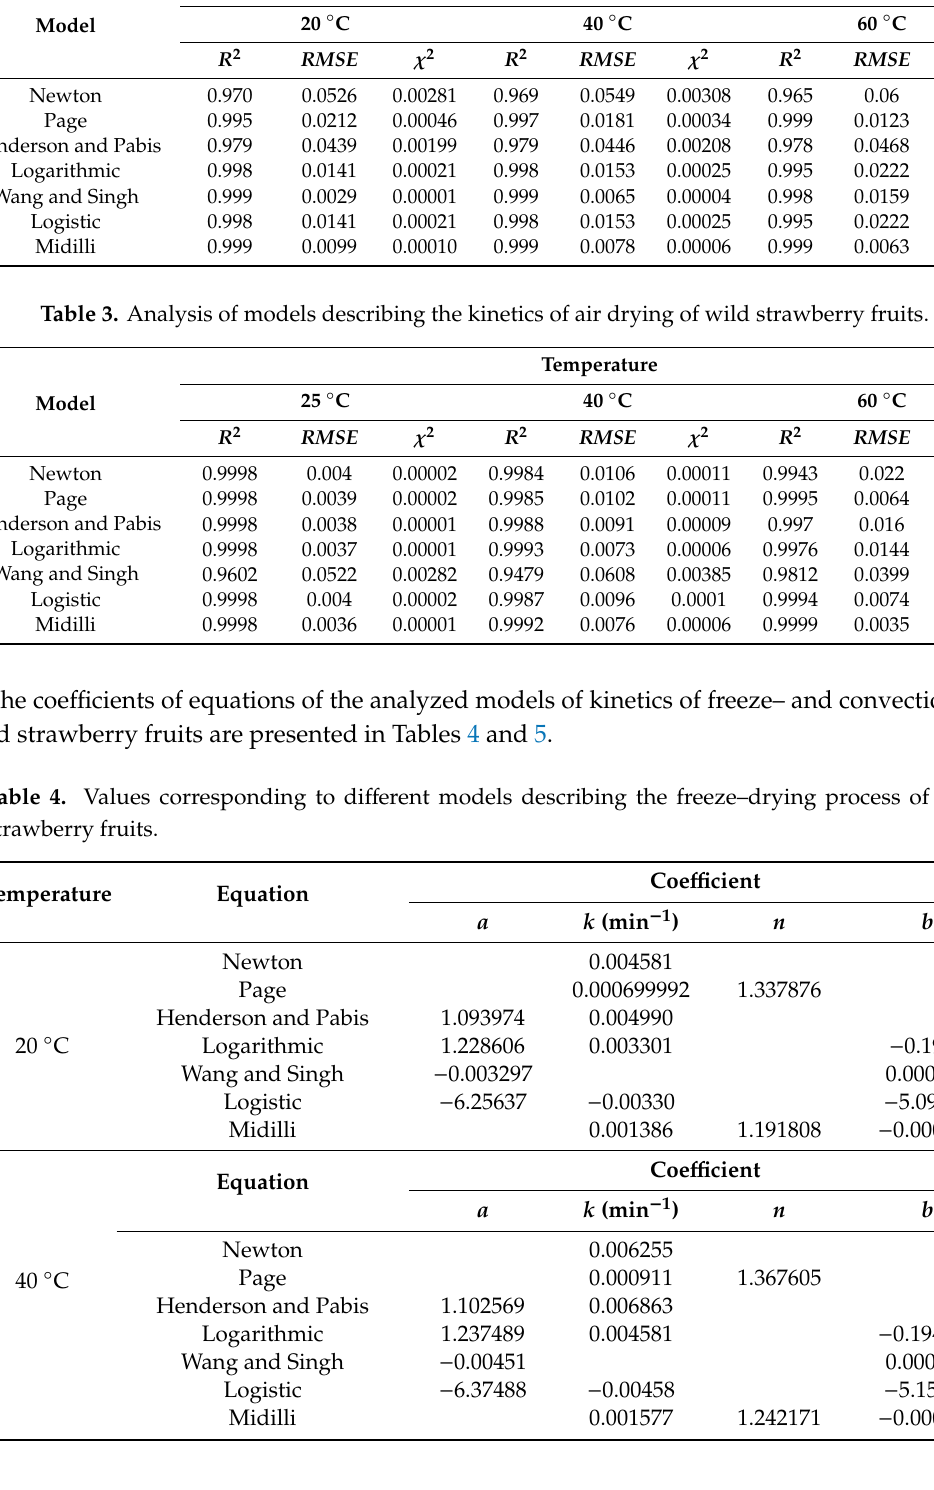
Table 2. Analysis of models describing the kinetics of freeze–drying of wild strawberry fruits.